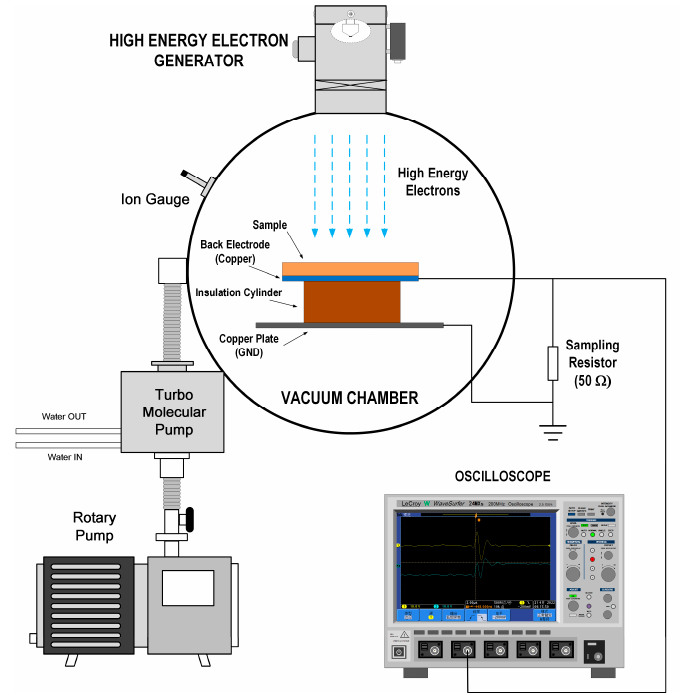
Figure 4. ESD testing system under high-energy electron radiation.